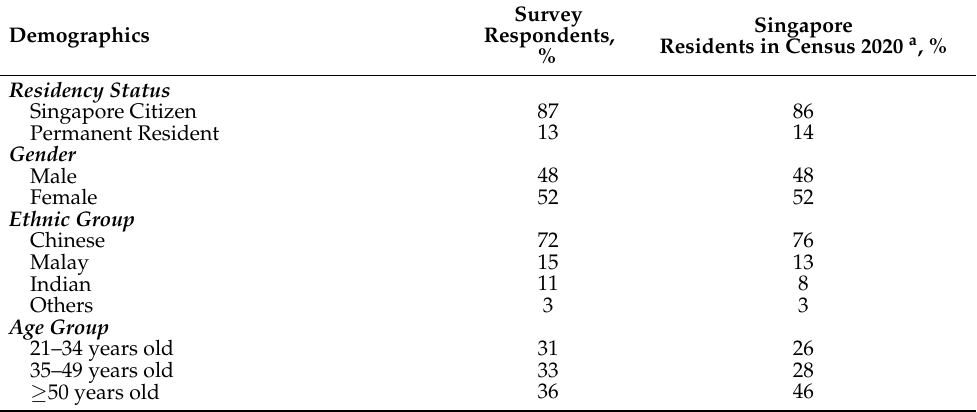
Table 1. Characteristics of 2004 Singapore residents surveyed between November 2020 and Jan- uary